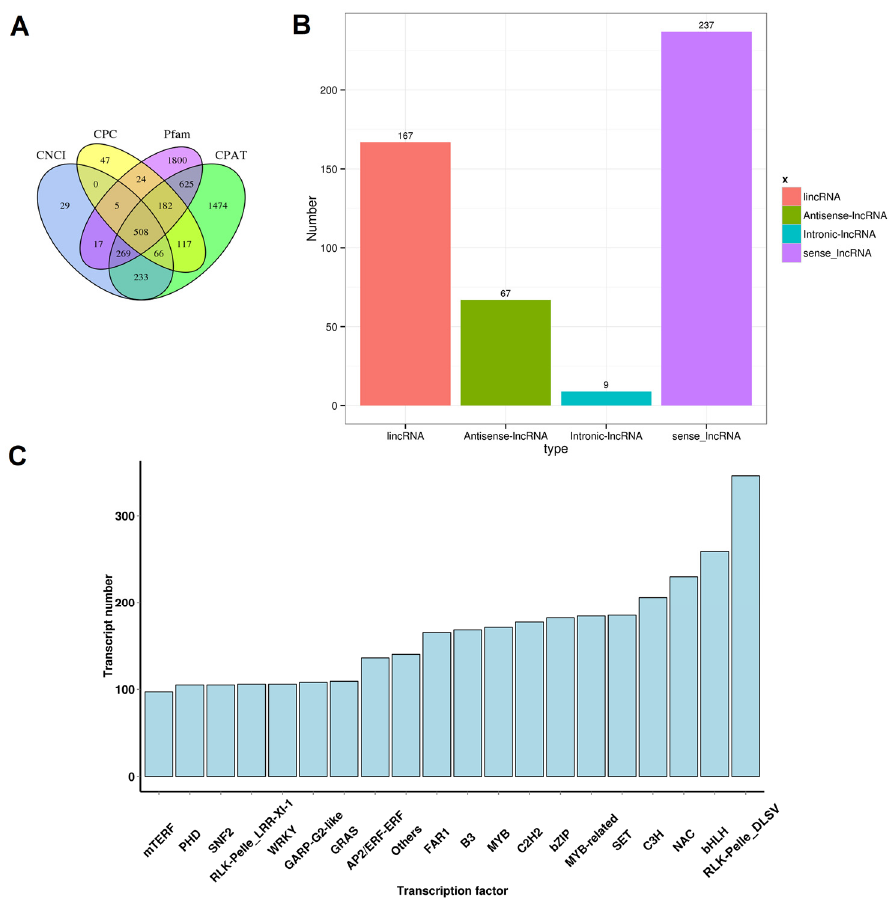
Figure 2. Prediction of lncRNAs and identification of TFs. ( A ) Venn diagram of lncRNAs filtered by CPC, CNCI, CPAT, and Pfam databases. ( B ) Classification of putative lncRNAs based on their relative physical locations with the related genes. ( C ) Classification of transcription factors.